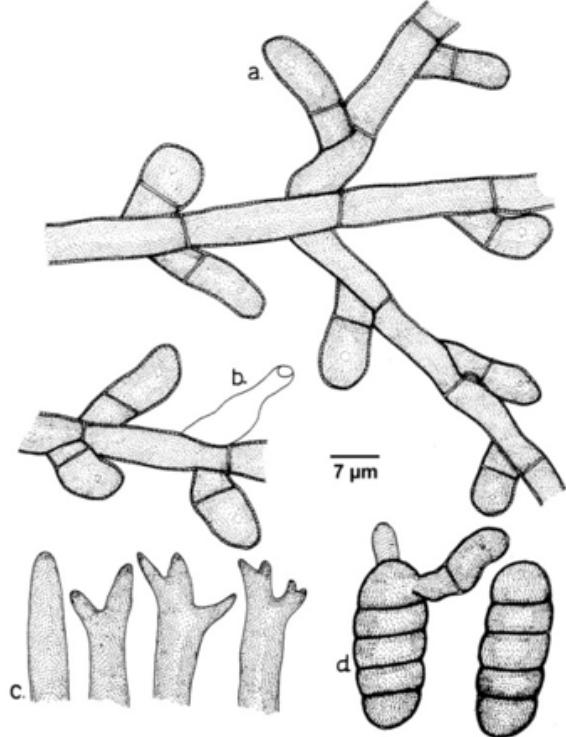
Figure 53. Meliola cadigensis var. g lycosmidis a - Appressorium; b - Phialide; c - Apical portion of mycelial setae; d -